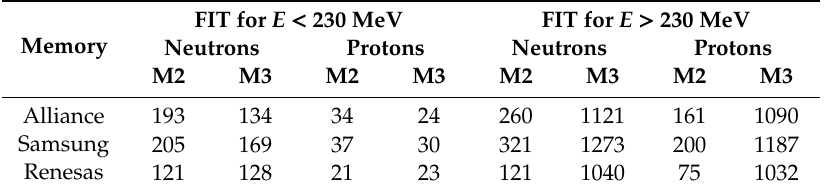
Table 3. FIT rate below and above 230 MeV due to neutrons and protons, using the characterization at 230 MeV (M2) and at GeV energies (M3). Calculation at 12 km of altitude.